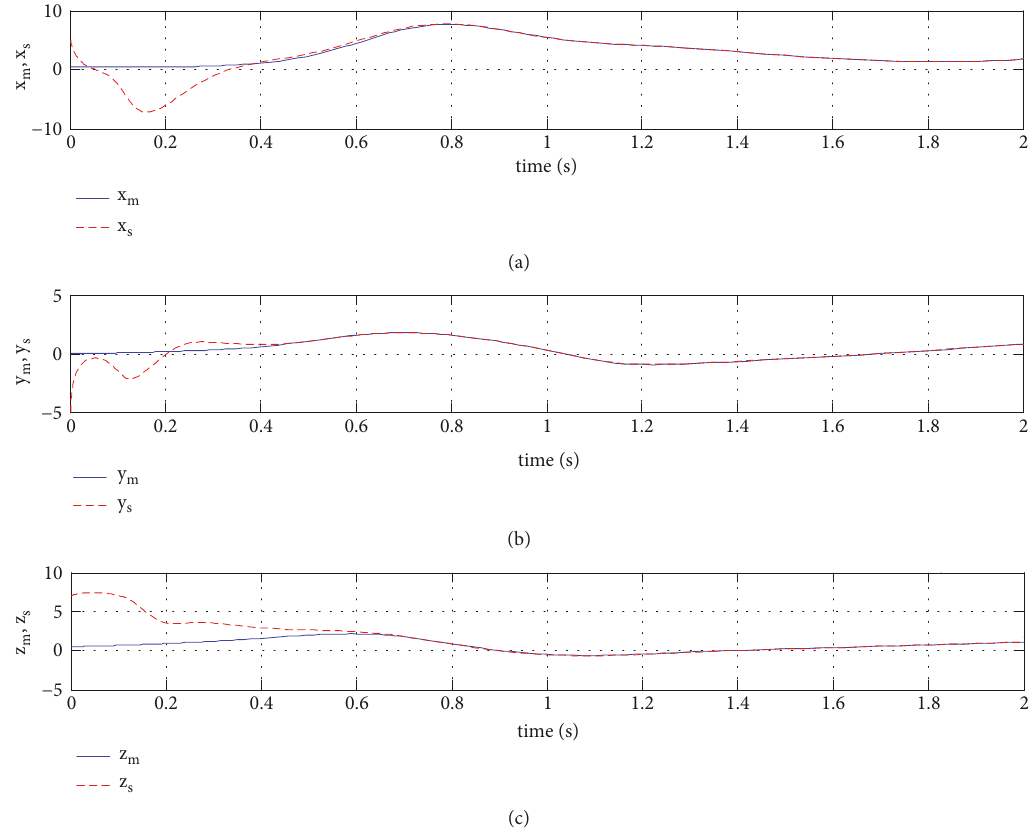
Figure 10: Adaptive synchronization process between slave system (4) and master system (3): (a) first state, (b) second state, and (c) third